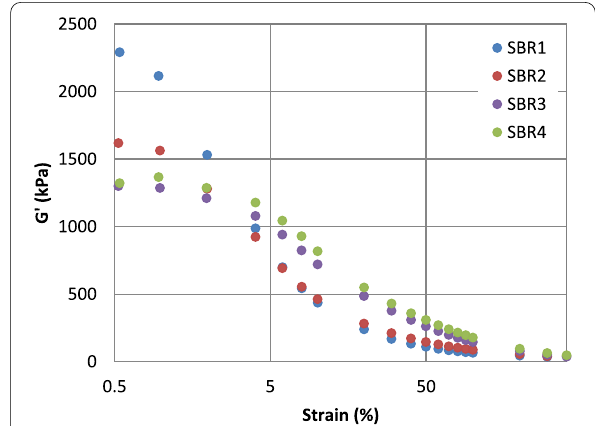
Fig. 10 Storage moduli at varying strains of silica–reinforced SBR compounds (linear type)